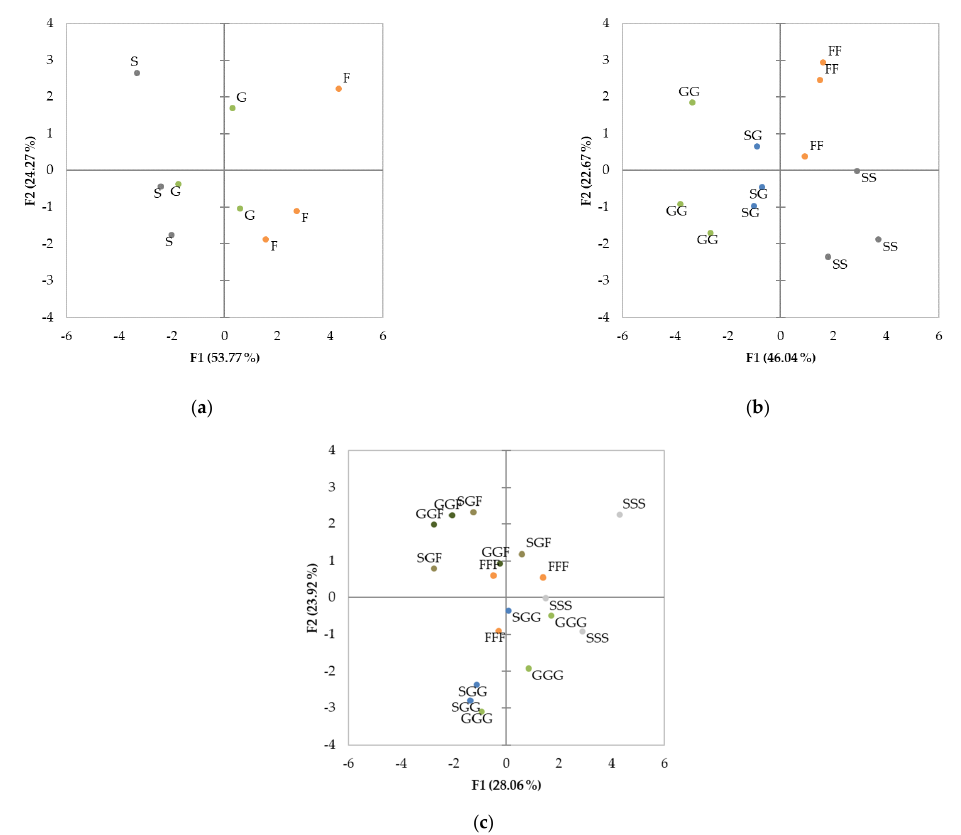
Figure 4. The PCA scatterplots, indicating distinct differences in photosynthetic performance of tomato, cultivated under different lighting spectrums during different growth stages: ( a ) seedling; ( b ) growth; ( c ) fruiting. S, G and F—lighting spectrum, selected for “seedling”, “growth” and “fruiting” stages respectively and alternated in seedling (S, G, F), biomass growth (SS, SG, GG, FF) and fruiting (SSS, SGG, GGG, GGF, FFF, SGF) tomato growth stages.